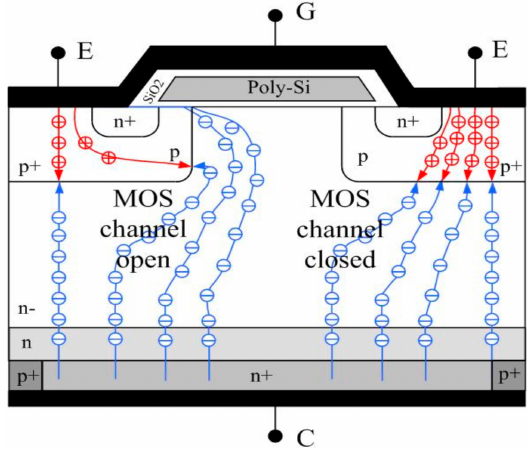
Figure 4. The internal charge dynamics of the RC-IGBT internal diode, whether the gate voltage is on or